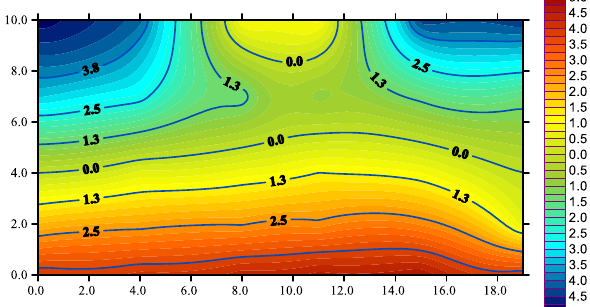
Fig. 23 Contours of hydraulic head (m) for the fifth problem with 30